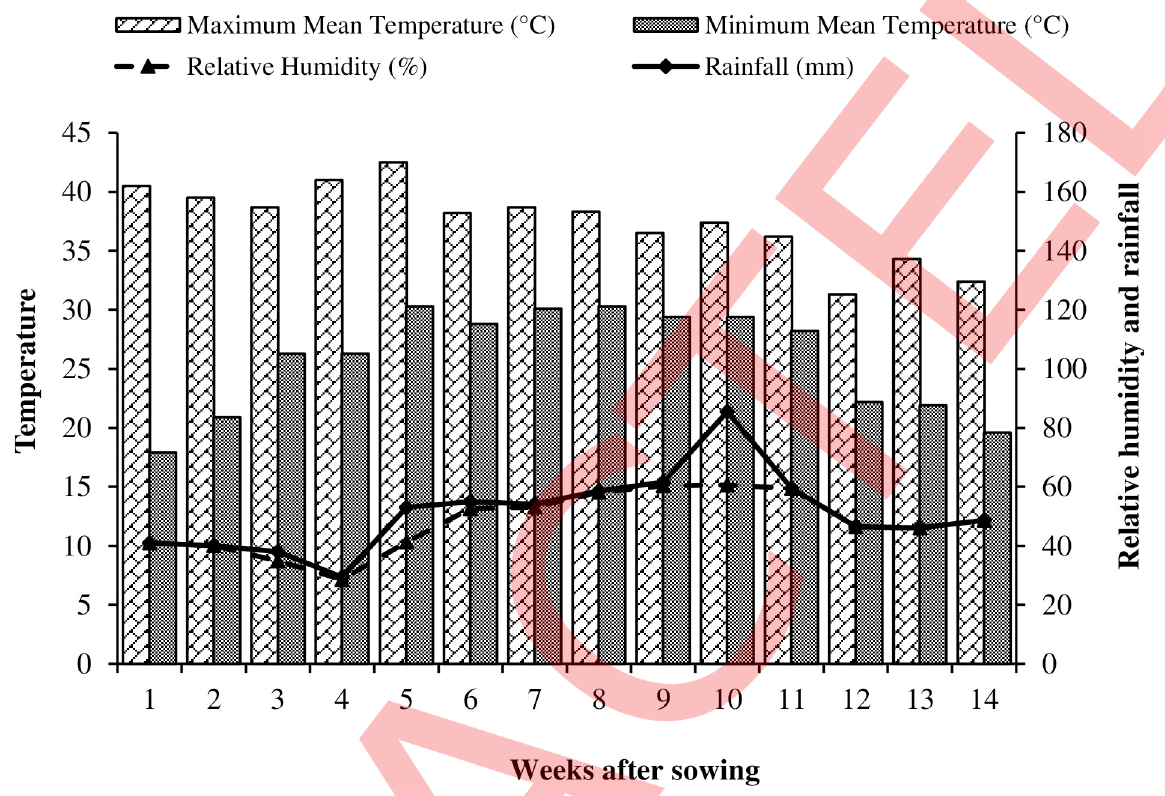
Fig 1. Meteorological data recorded at Bahauddin Zakariya University, Multan during experimental period.